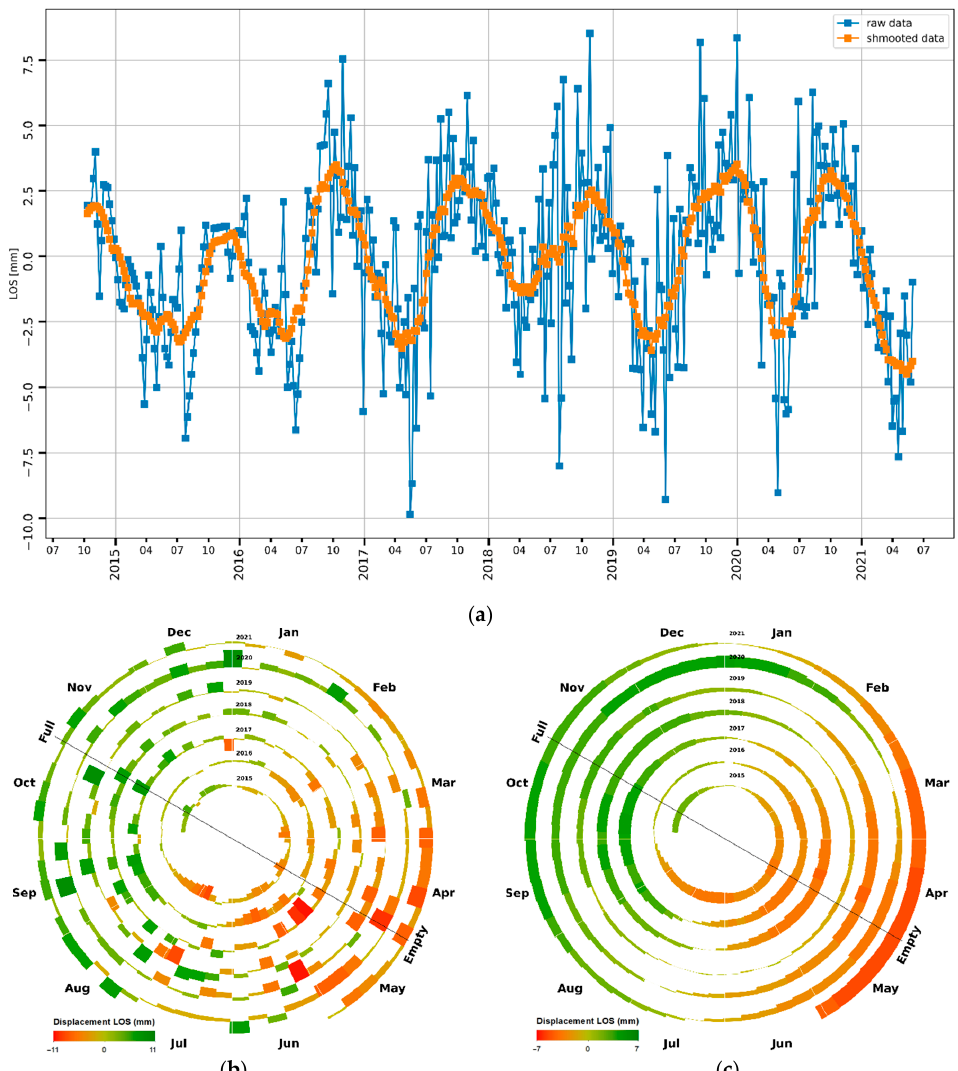
Figure 1. Example of time series visualisation of a single cluster time series. ( a ) The line graph of the raw and smoothed data. ( b ) The spiral graph of the raw data. ( c ) The spiral graph of the data smoothed by a simple moving average with a 90-day